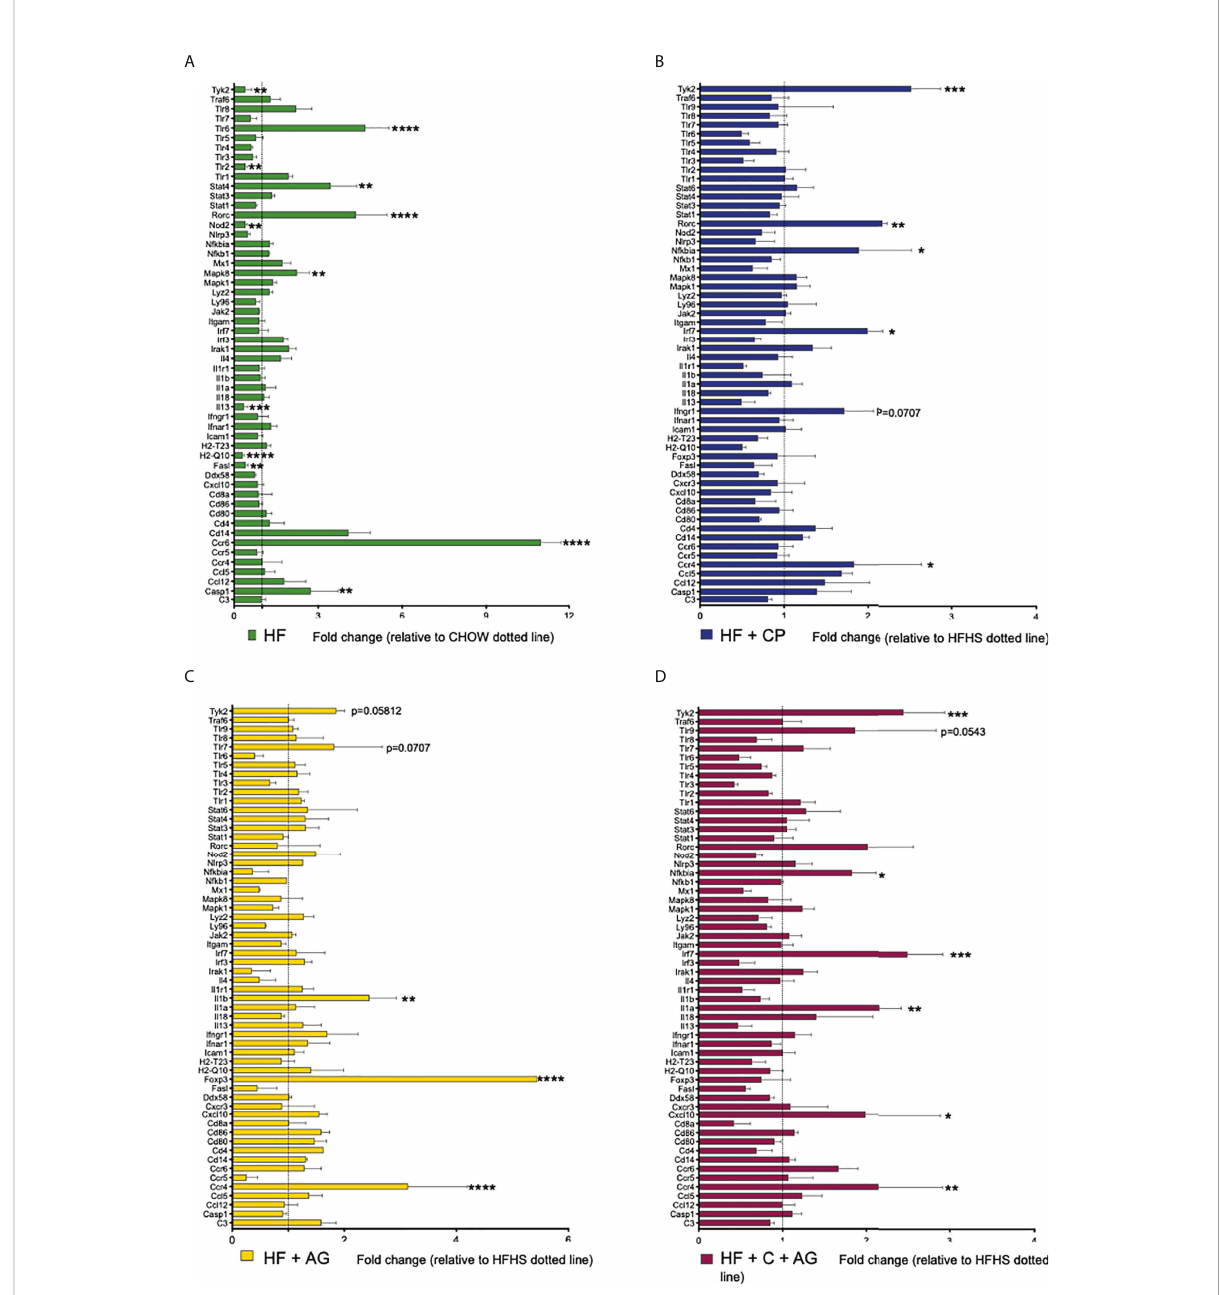
FIGURE 6 Effects of cranberry polyphenols (CP) and agavins (AG) in the modulation of innate and adaptive immune markers in HFHS-diet induced obese mice. An analysis of the expression pro fi le of 84 genes associated with adaptive and innate immunity was performed in colon samples by microarray technology (Qiagen #330231 PAMM-052ZA). Mice were fed either a chow diet (CT) or high-fat high-sugar diet (HF); mice on an HF diet were supplemented with CP (HF+CP), AG (HF+AG), or the combination of both CP+AG (HF+CP+AG) for 9 weeks. Fold change of the panel of genes expressed in (A) HF relative to CT; (B) HF+CP relative to HF; (C) HF+AG relative to HF; and (D) HF+CP+AG relative to HF. The control HFHS group is displayed as a dotted line normalized to 1.0. Fold change to the right of the dotted line represents upregulation, and fold change to the left of the dotted line represents downregulation. Fold change was calculated using the DD Ct method; each gene was normalized to the expression level of the reference genes: glyceraldehyde-3-phosphate dehydrogenase ( Gapdh ), glucuronidase beta ( Gusb ), and heat shock protein 90 alpha (cytosolic), class B member 1 (Hsp90ab1). Two-way ANOVA was performed to calculate the signi fi cance of the differences between groups. *p < 0.05, **p < 0.01, ***p < 0.005, ****p <